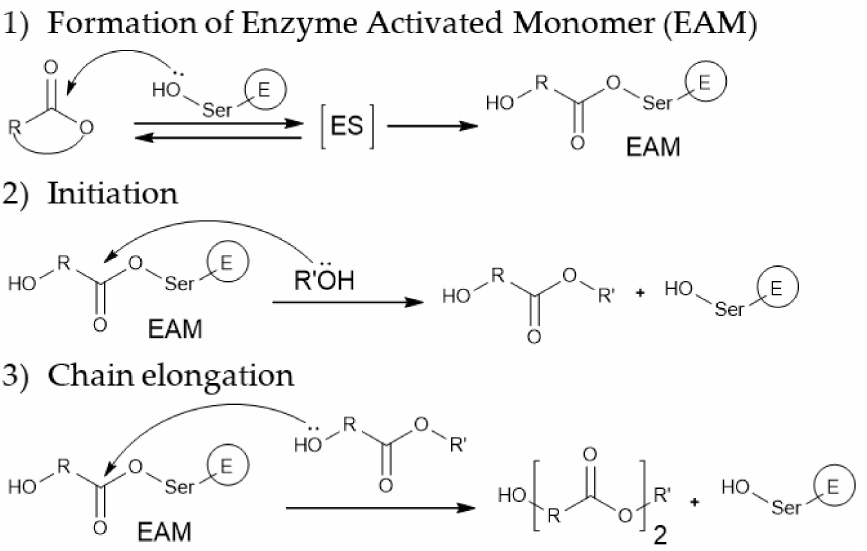
Figure 8. Lipase-catalyzed lactone polymerization mechanism. R represents a group of the lactone molecule; R (cid:48) —H,